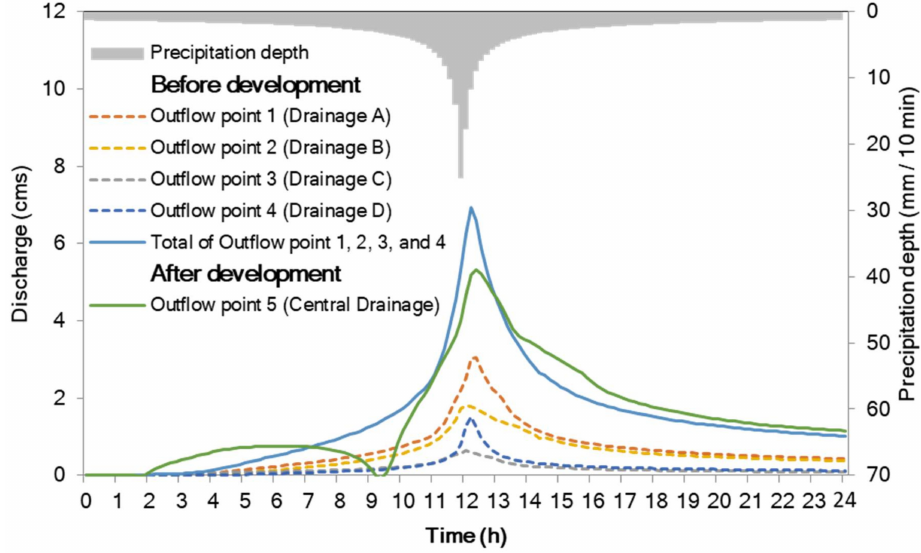
Figure 5. The outflow hydrograph of 100-year return period before and after land